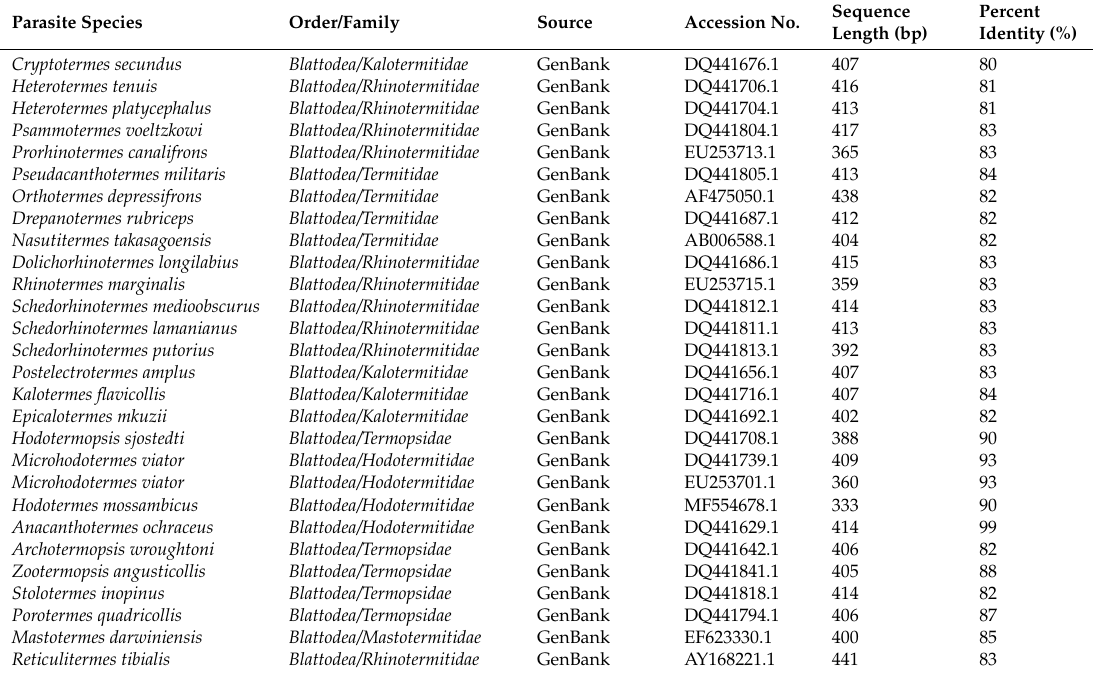
Table 1. Termitid species used in the phylogenetic analysis of the present A. ochraceus. Parasite